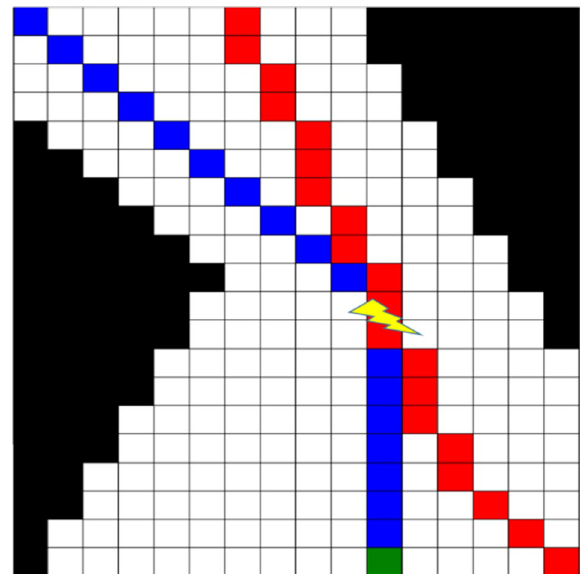
Fig. 15 Path planning results of traditional A* algorithm. The experimental results of the traditional A* algorithm are shown in this figure. We can observe that the traditional A* algorithm can avoid all static obstacles well, and the path length is optimal. However, it is difficult for traditional A* algorithm to effectively avoid the straight ships whose position changes dynamically in each round, resulting in the collision between the give-way ship and the direct-sailing ship at the yellow